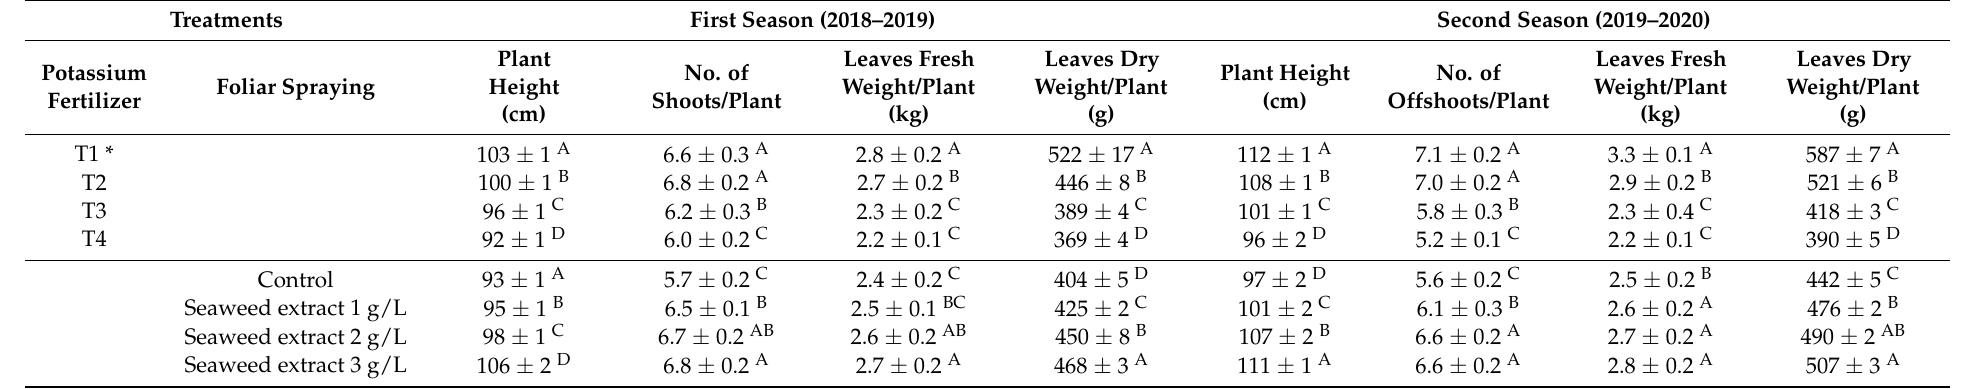
Table 4. The effect of potassium fertilizer, biofertilizer, and foliar spraying of seaweed extract on globe artichoke vegetative growth